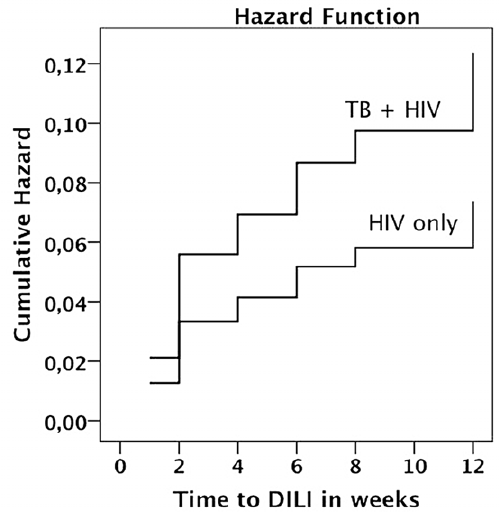
Figure 1. Kaplan-Meier curves indicating estimate cumulative hazard for the development of drug induced liver injury between HIV patients receiving efavirenz based HAART alone and TB-HIV coinfected patients receiving efavirenz based HAART with rifampicin based anti-TB therapy during the first three months of follow up period.